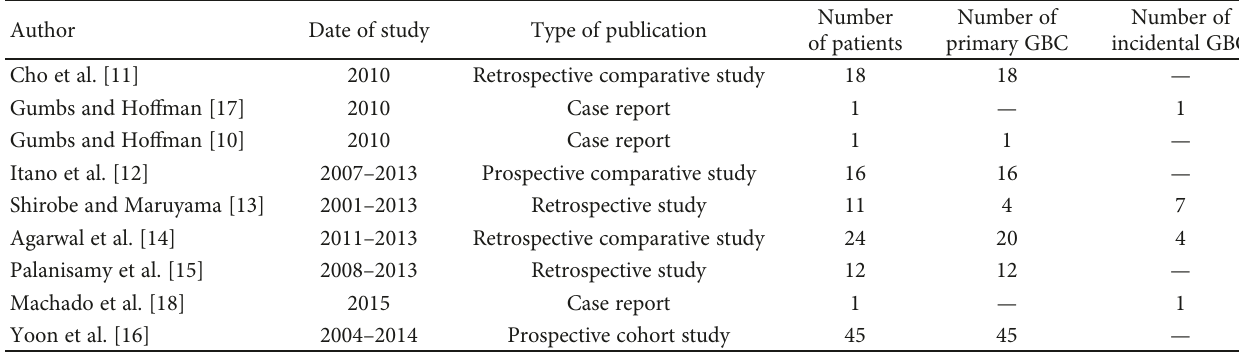
Table 1: Studies.